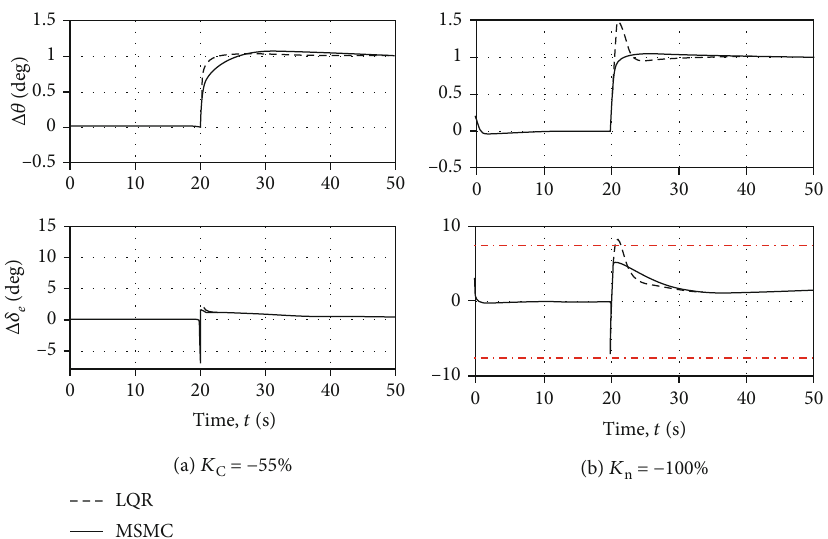
Figure 7: Nonlinear simulation of step reference with input saturation.